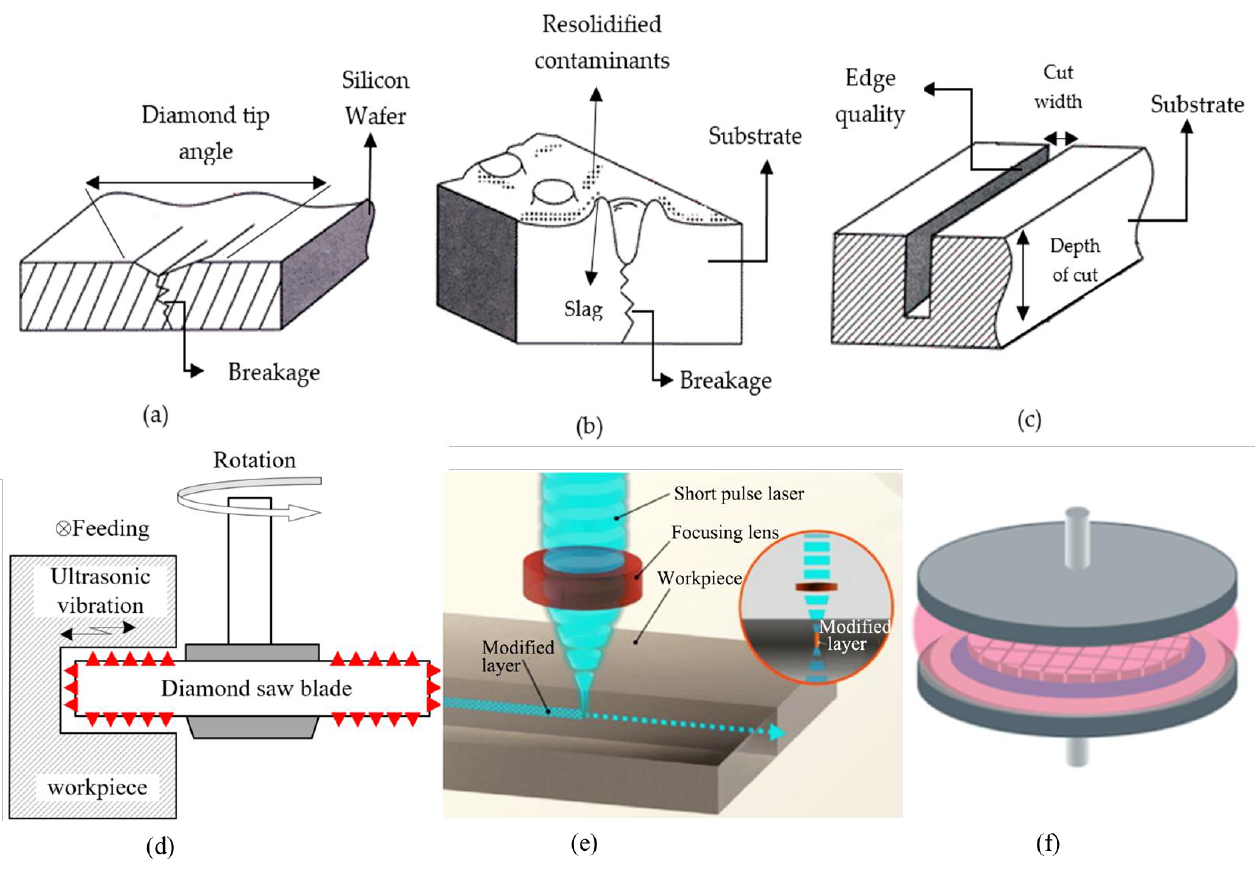
Figure 1. Die separation techniques: ( a ) diamond scribing; ( b ) laser scribing; ( c ) diamond wheel dicing; ( d ) ultrasonic dicing; ( e ) stealth dicing; ( f ) plasma dicing [7,9,11,12]. Adapted with permission from Ref. [11]. 2015, Elsevier.